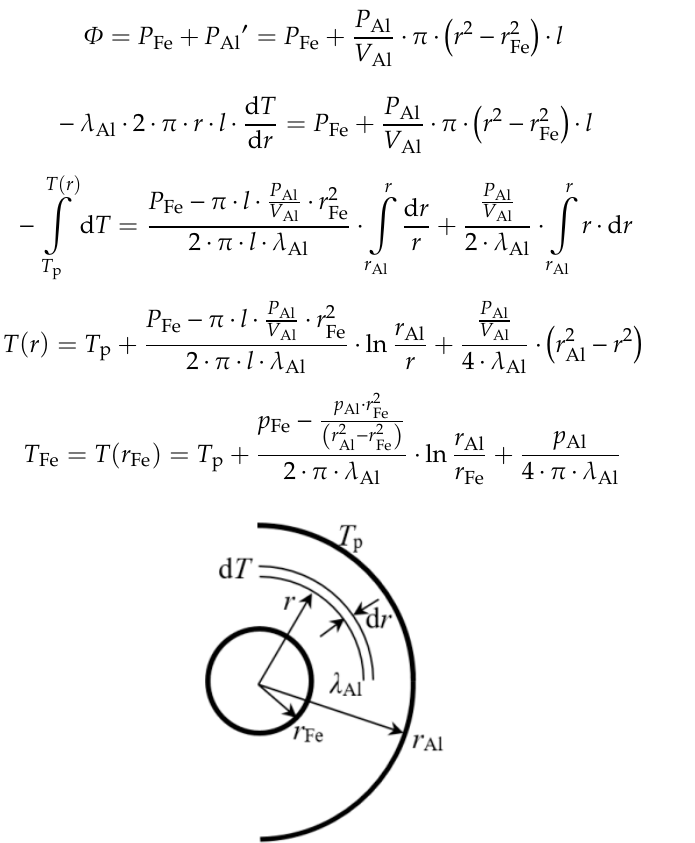
Figure 6. Heat current from the steel core. Note: r is appropriate radius, T appropriate temperature, λ appropriate conductivity.